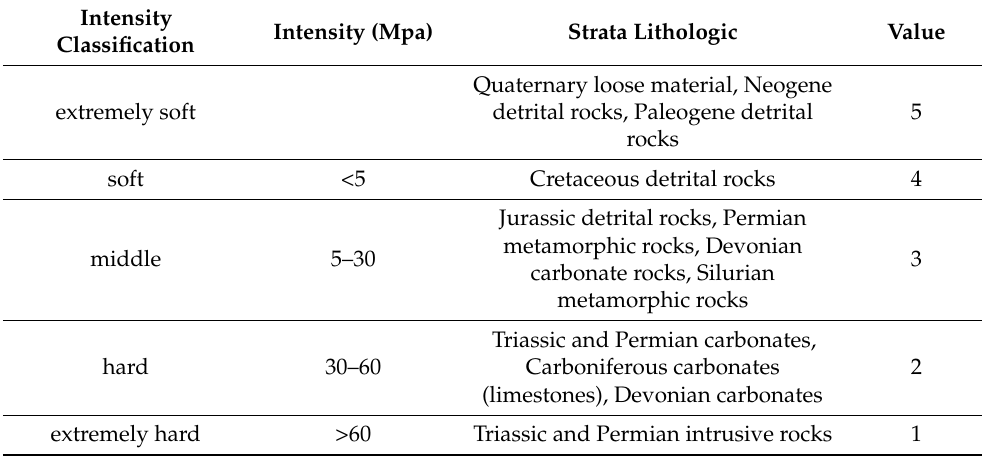
Table 2. Strata lithologic strength classification.